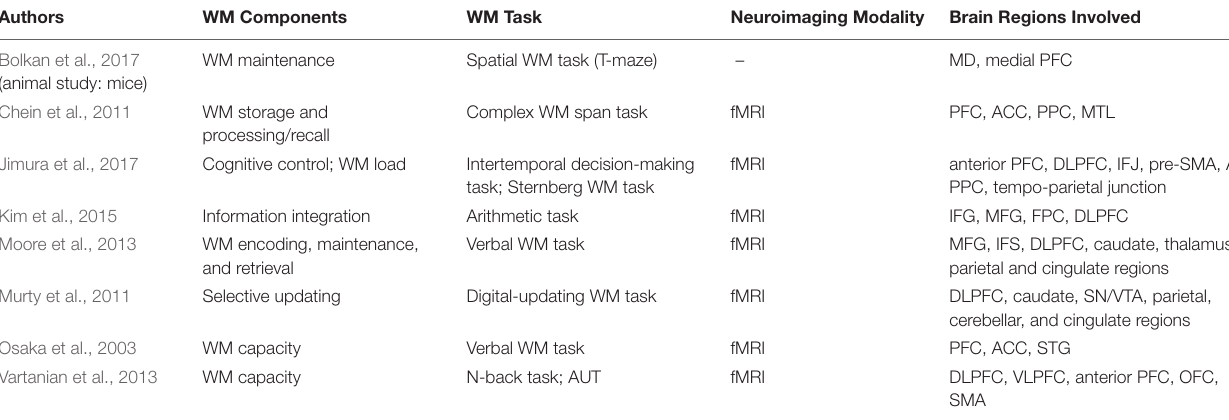
TABLE 1 | Working memory (WM) studies in the healthy brain.